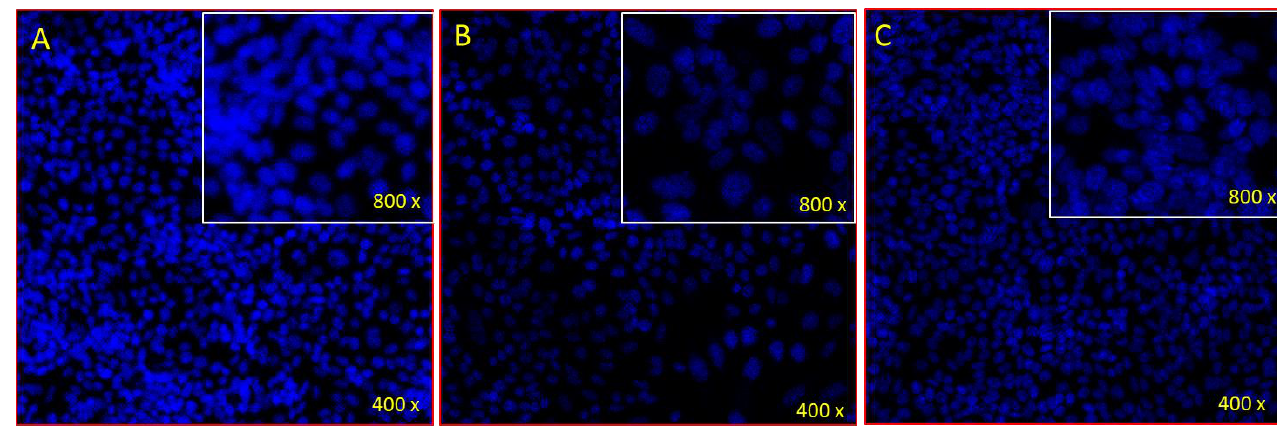
Figure 17. Effects of chrysophanol on HeLa, HCT-116 and HEK-293 cells cell viability assessed by MTT assay. ** p < 0.01.